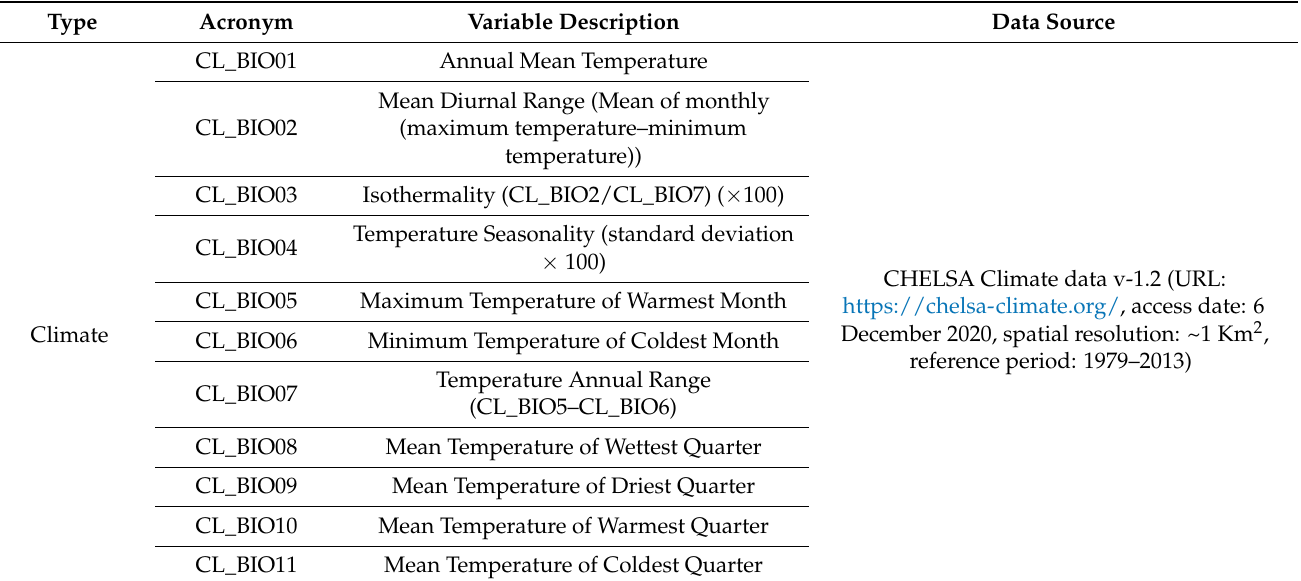
Table A2. Full list of variables used for modelling landscape drivers of Acacia invasion, their acronyms and data sources.